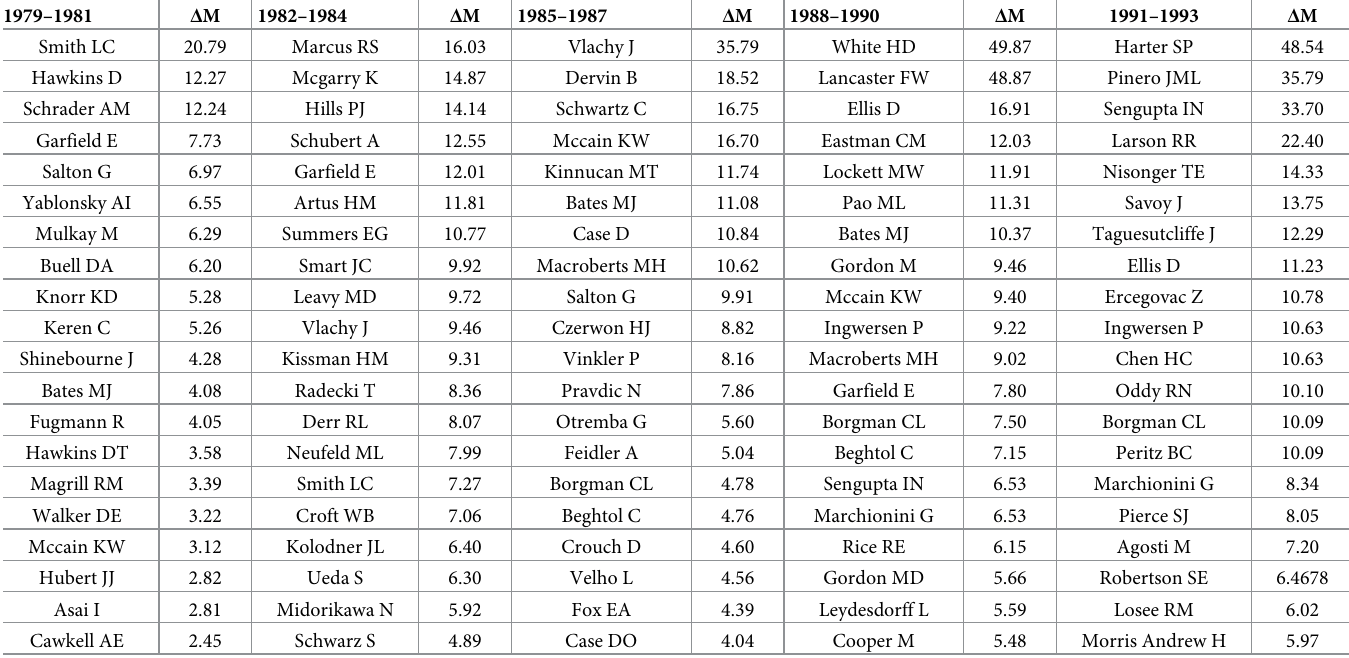
Table 6. Top 20 researchers with the largest Δ M in each of the 3-year time intervals (1979–1993). 1979–1981